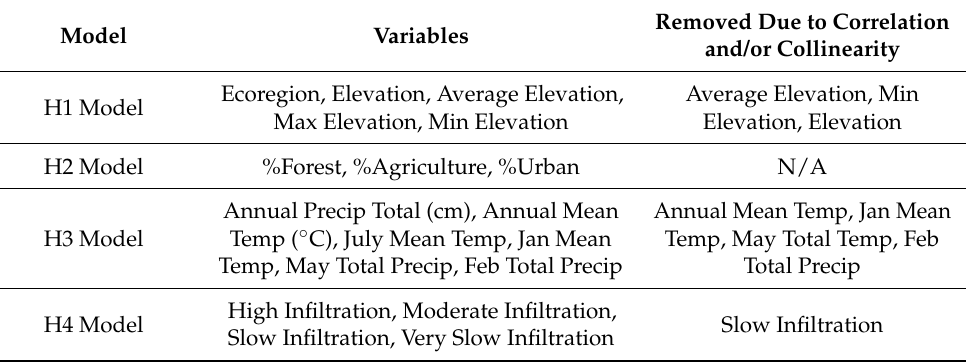
Removed Due to Correlation and/or Collinearity Average Elevation, Min Elevation, Elevation Annual Mean Temp, Jan Mean Temp, May Total Temp, Feb Total Precip Slow